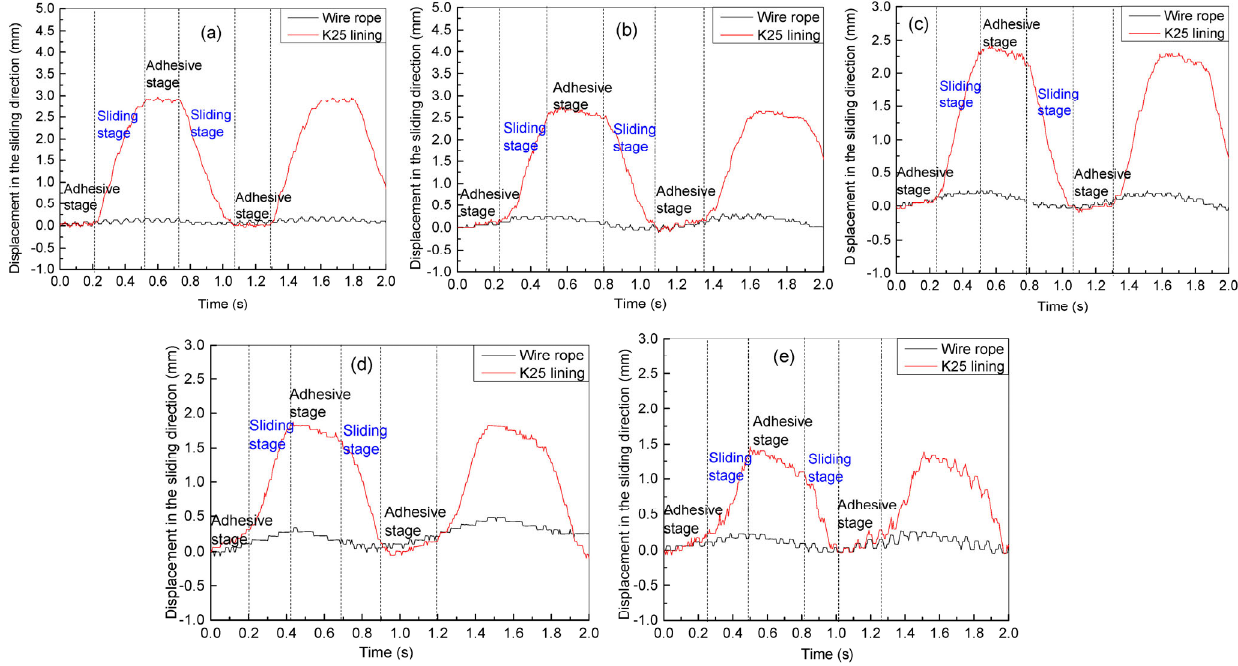
Fig. 5 Displacement of the K25 lining and wire rope in the sliding direction at: (a) 1, (b) 1.5, (c) 2, (d) 2.5, and (e) 3